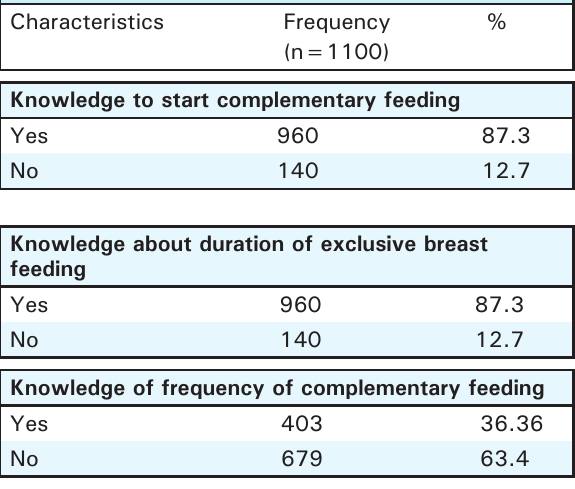
Table 2. Mother’s knowledge related characteristics of infant and young child feeding.